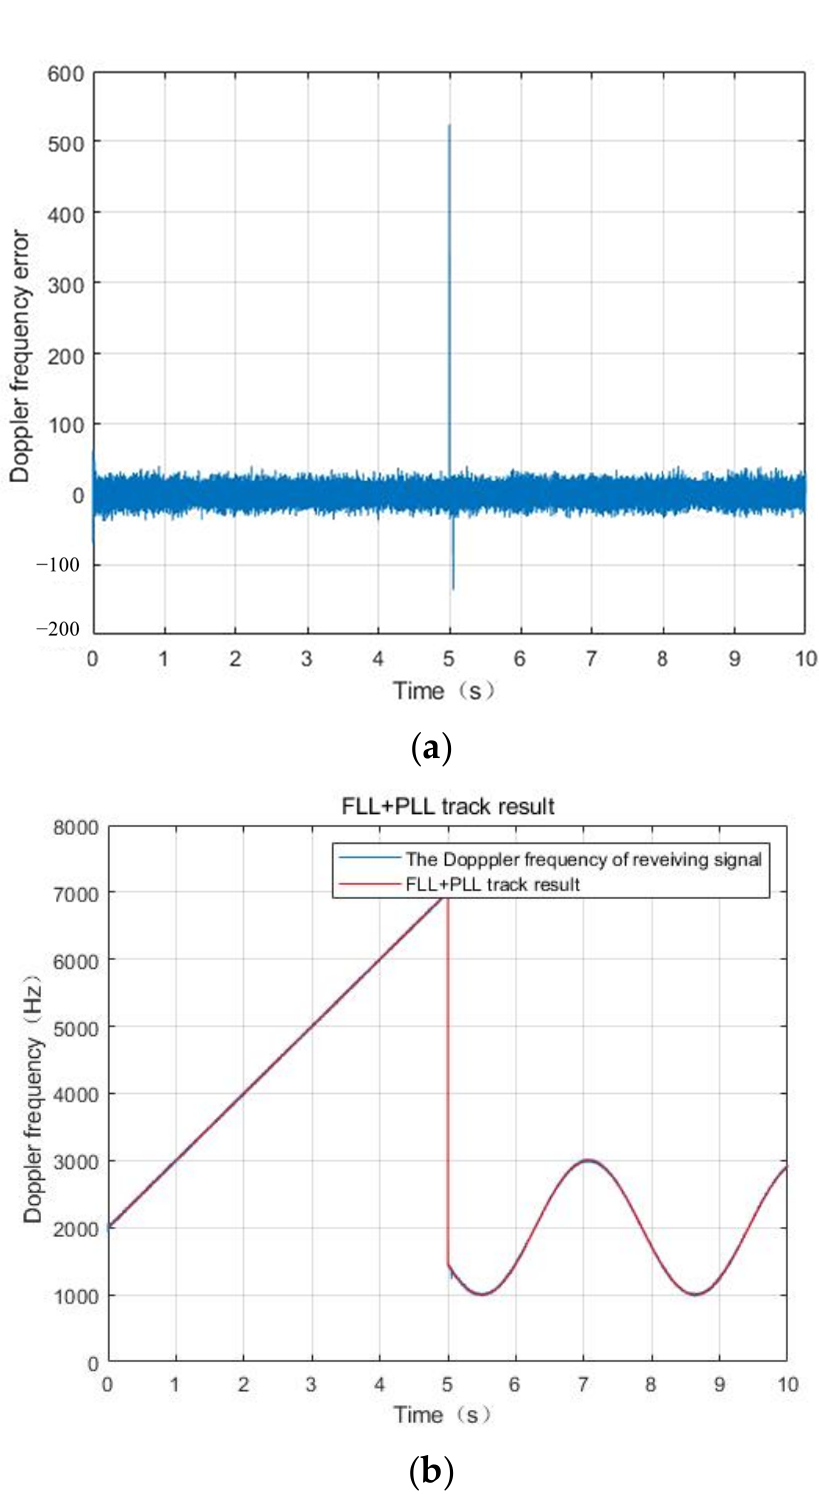
Figure 14. The switching time when α : β = 0.1 : 0.9 and C / N 0 = 65 dB-Hz. ( a ) the Doppler frequency error, and ( b ) the Doppler frequency measurement.